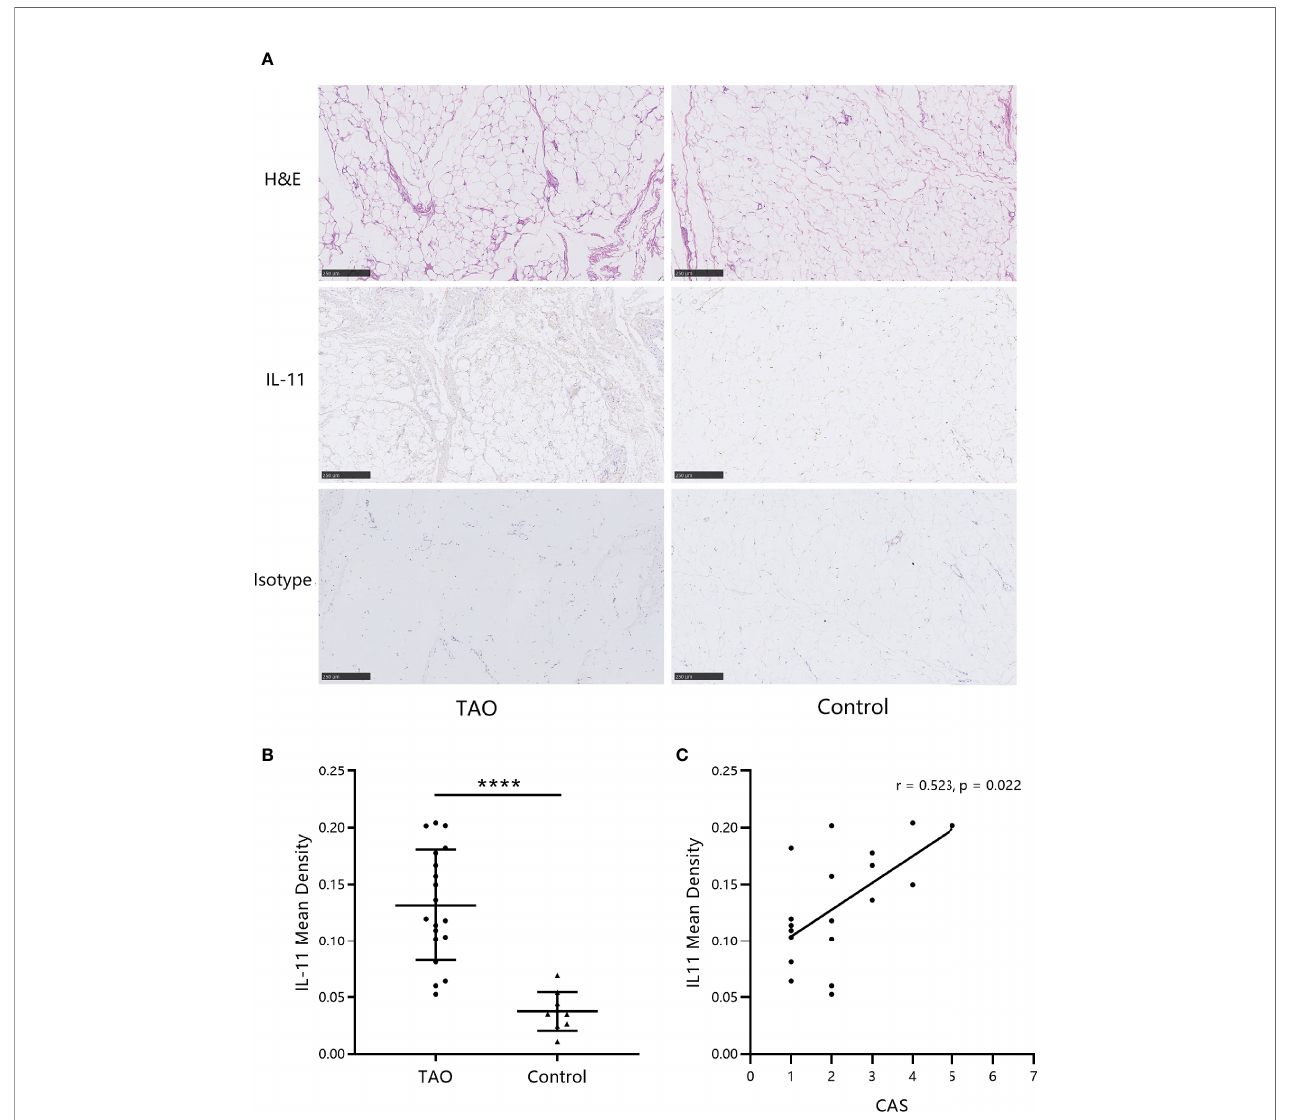
FIGURE 2 | IL-11 expression in orbital connective tissues of thyroid-associated ophthalmopathy (TAO) patients is augmented. (A) Immunohistochemistry (IHC) staining was performed on paraf fi n-embedded biopsy sections. The positive IHC staining of IL-11 was shown as yellowish-brown. One representative staining for each group of biopsies is shown. Scale bars, 250 m m. (B) The mean density was used for the semi-quantitative analysis of IHC (TAO, n = 19; control, n = 10). The data are expressed as the mean ± standard deviation (SD). ****P < 0.0001. assessed by two-tailed student ’ s t-test. (C) Correlation between the Clinical Activity Score (CAS) and IL-11 mean density in patients with TAO. H&E, hematoxylin and eosin. Spearman ’ s test was used for the correlation analysis. P < 0.05 was considered signi fi